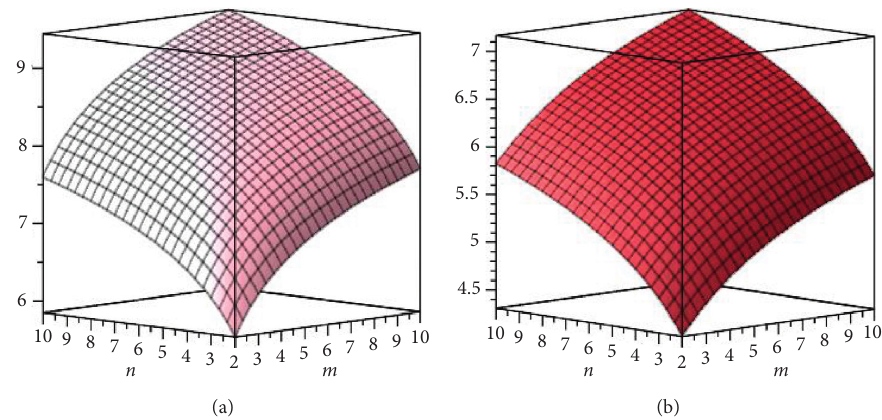
Figure 10: (a) The augmented Zagreb entropy; (b) the Balaban entropy.